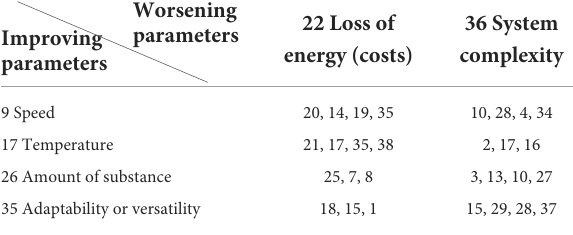
TABLE 12 TRIZ contradiction matrix